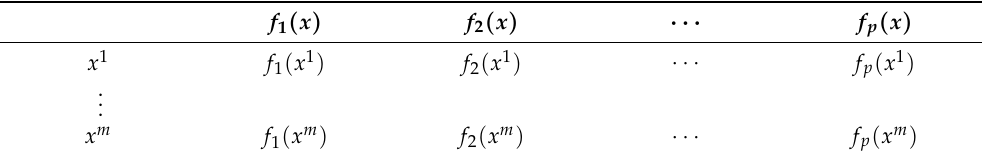
Table 2. Decision table.